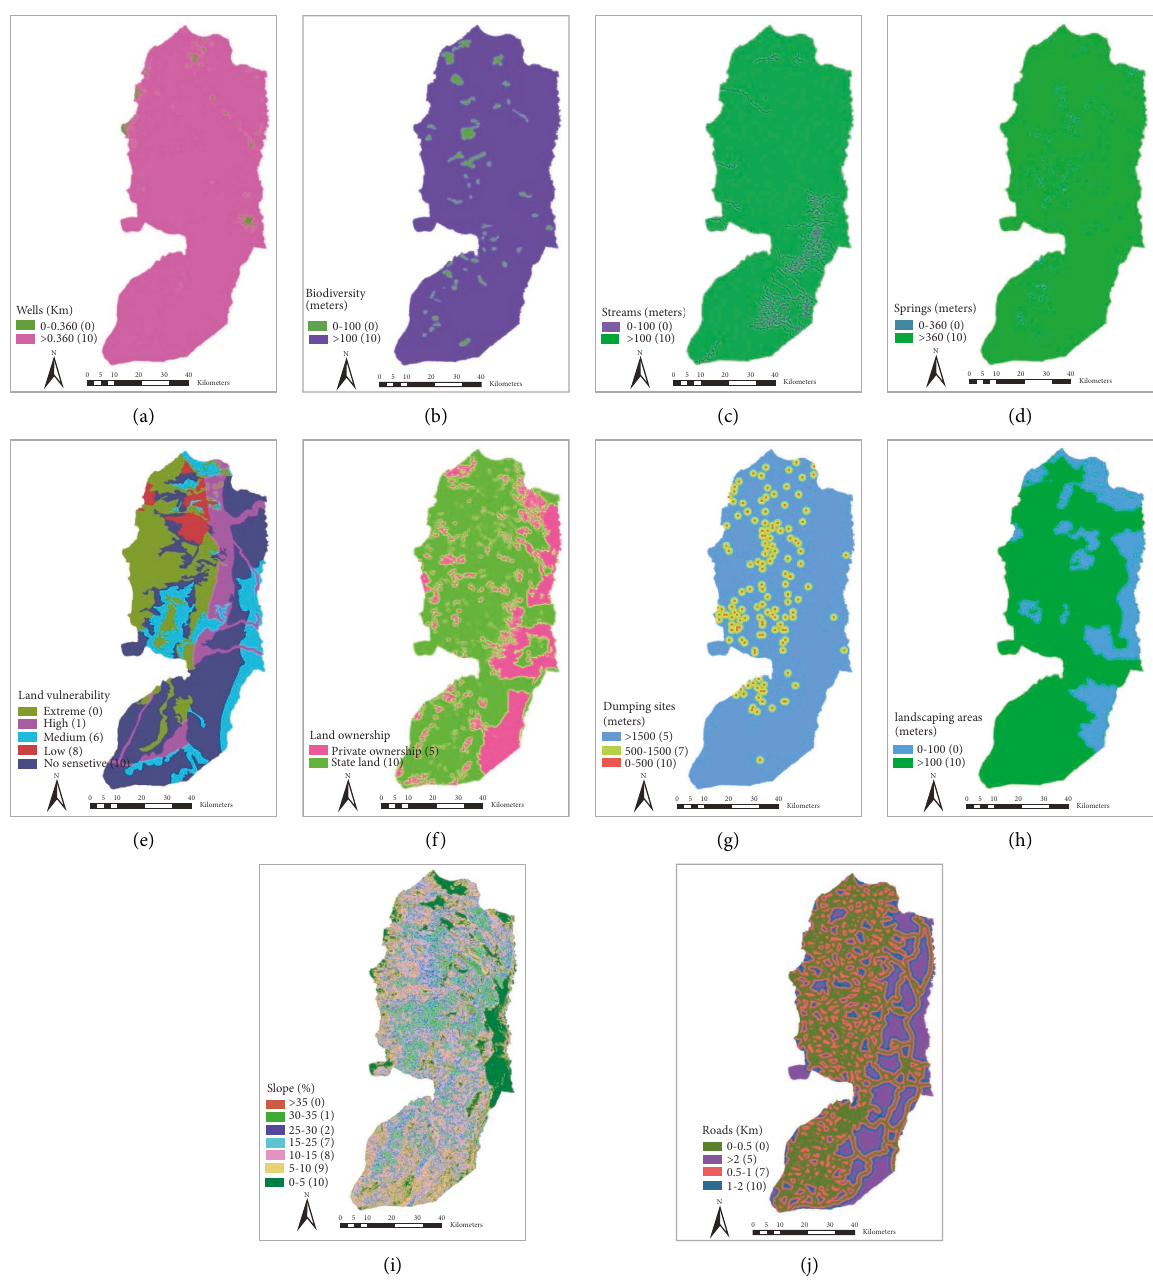
Figure 5: Subcriteria ranks (maps prepared by researcher, dataset source: GeoMoLG). (a) Map 1. (b) Map 2. (c) Map 3. (d) Map 4. (e) Map 5. (f) Map 6. (g) Map 7. (h) Map 8. (i) Map 9. (j) Map